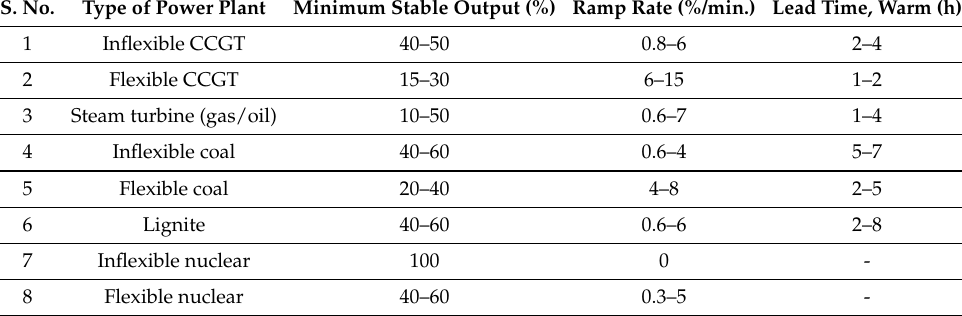
Table 11. Characteristics of flexible and inflexible power